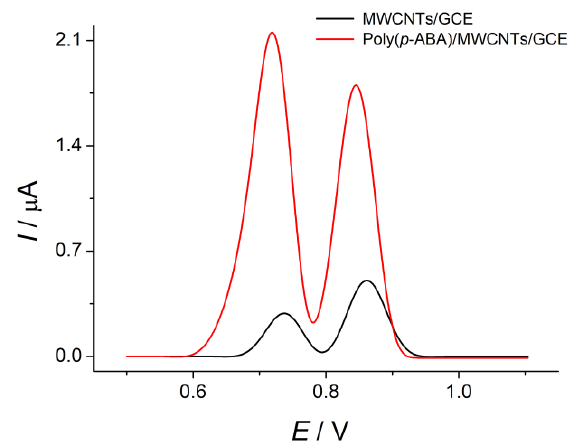
Figure 6. Baseline-corrected differential pulse voltammograms of 10 µM mixture of syringaldehyde and vanillin at the MWCNTs/GCE and poly( p -ABA)/MWCNTs/GCE in Britton–Robinson buffer pH